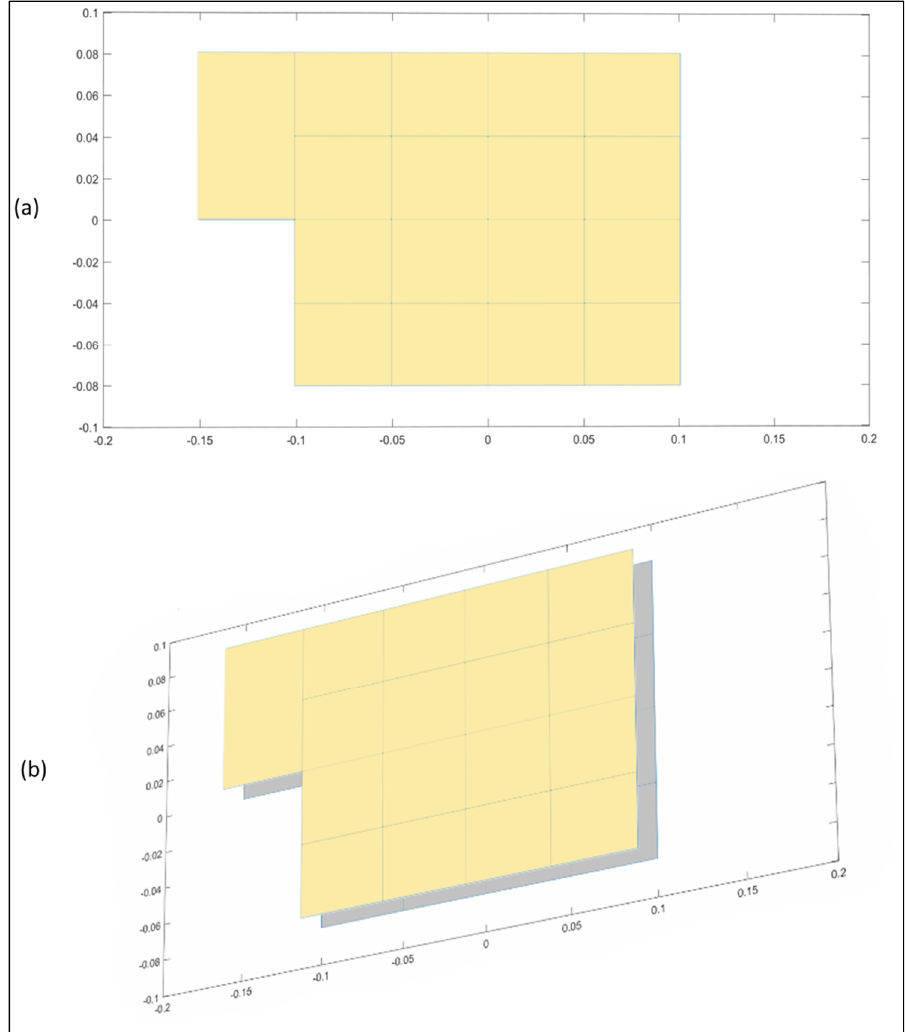
Figure 1. Depictions of a battery cell constituted of coupled positive and negative plates. ( a ) Top view of plate partitioned into 16 subareas. The relatively large rectangular segment on the left side corresponds to the current collector tab of each plate. ( b ) 3D depiction of cell’s top view. Top layer (yellow) is the positive plate, and bottom layer (grey) is the negative plate. The scales show the dimension of the battery cell (Unit: m).